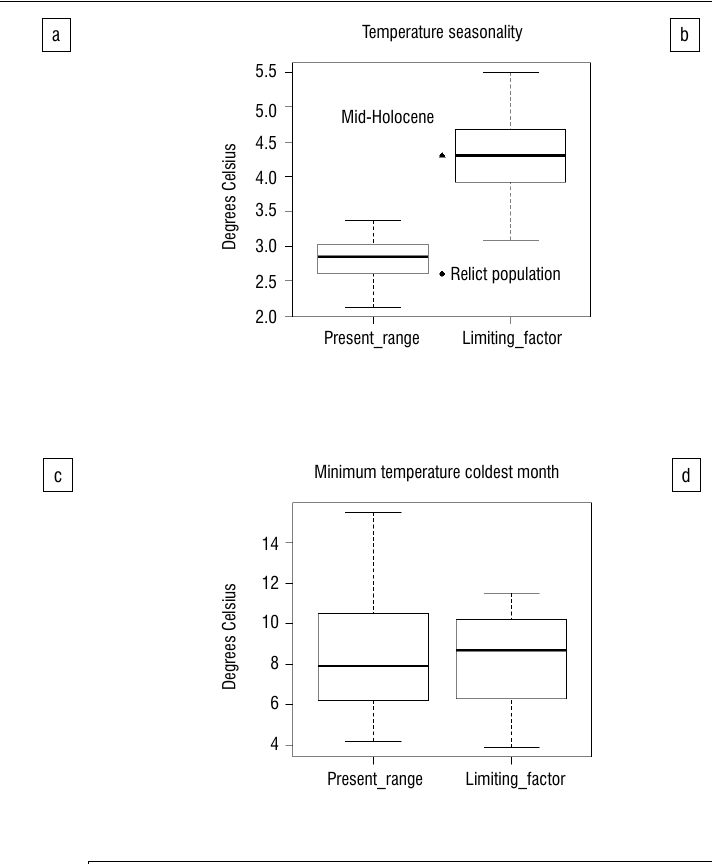
The box plot represents the fundamental niche, with the interquartile range (box with median present) representing 50% of the total data values and the upper and lower whiskers representing 25% of the values, respectively. The interquartile space is interpreted as the ‘most suitable’ range of climatic or environmental conditions for the species, while the lower and upper whiskers span less suitable conditions, reflecting lower and upper tolerance limits, respectively. Extreme values, beyond the 1.5 coefficient value, are shown as open circles; palaeohistoric (solid triangle) and relict population (solid circle) values are included for comparison. Figure 3: Comparative box plots for the present-day range (76 quarter- degree-square (QDS) centroid points) of the ecological niche of Brachystegia spiciformis woodland in southern Africa and a limiting factor (76 adjacent, randomly selected QDS centroid points) for five bioclimatic layers (a) precipitation of wettest quarter, (b) temperature seasonality, (c) maximum temperature warmest month, (d) minimum temperature coldest month and (e) precipitation